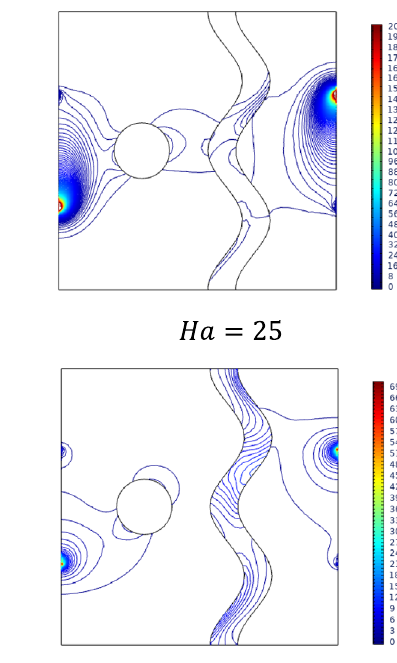
Figure 19. Variations of the general entropy with various Hartmann number Ha at Ra 0.2 and ω 0.02 , ε 2 , φ N = = =